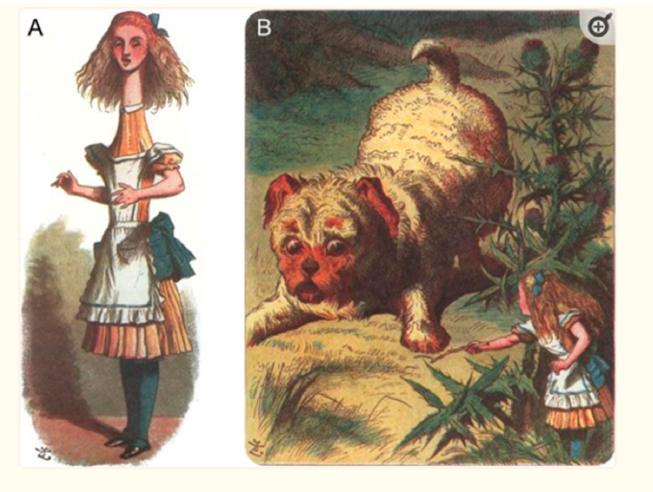
Figure 2. ( A ) Alice experieces partial macrosomatognosia, and ( B ) Alice experiences total-body microsomatognosia. Illustrations by John Tenniel (1890). Note: Alice in Alice in Wonderland. Adapted from “Alice in Wonderland Syndrome,” by Blom, J. 2016, The Journal of NIH Research , V6(3): 259–270. Copyright 2016 Adapted with